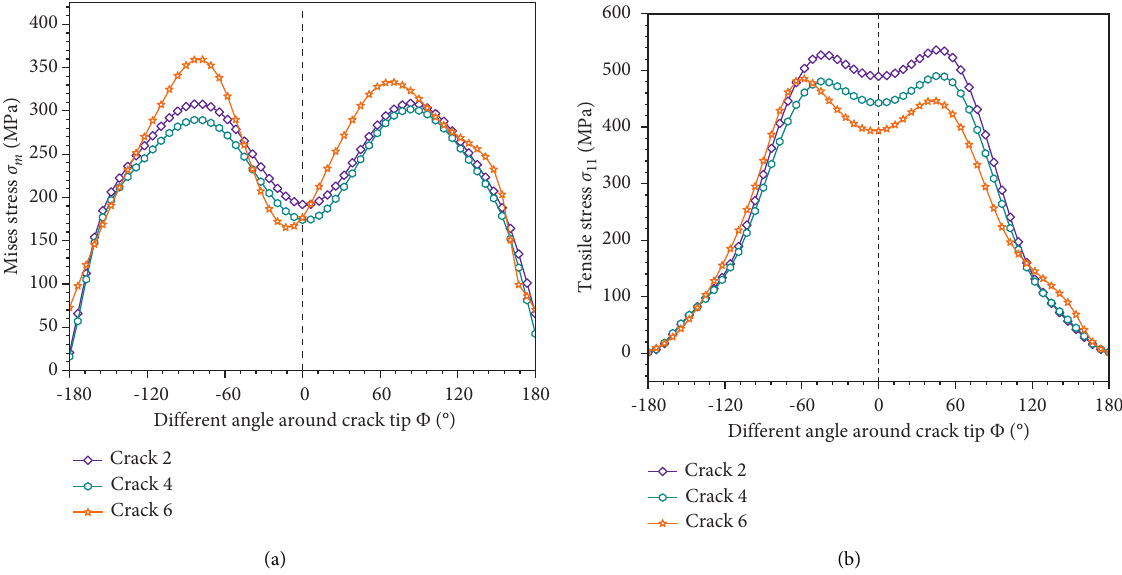
Figure 8: The stress curve at the crack tip of the interface. (a) Mises stress and (b) tensile